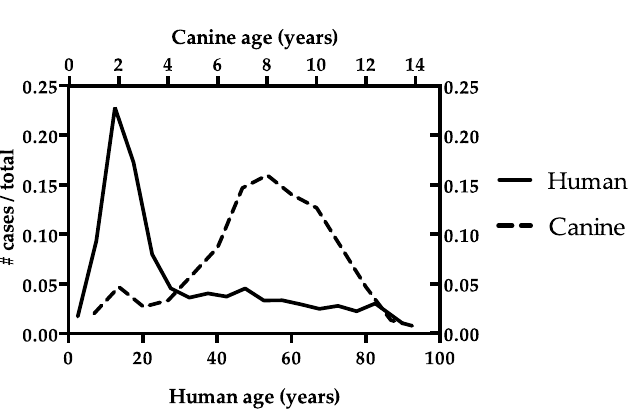
Figure 1. Age at diagnosis of osteosarcoma in dogs and humans. The data are represented as the number of cases diagnosed at each age out of the total number of osteosarcoma cases. Human data (n = 4071) are compiled from the SEER 18 database [8]. Canine cases (n = 150) of histopathologically-confirmed appendicular osteosarcoma, complied from the authors’ database, are consistent with published data [16–19].